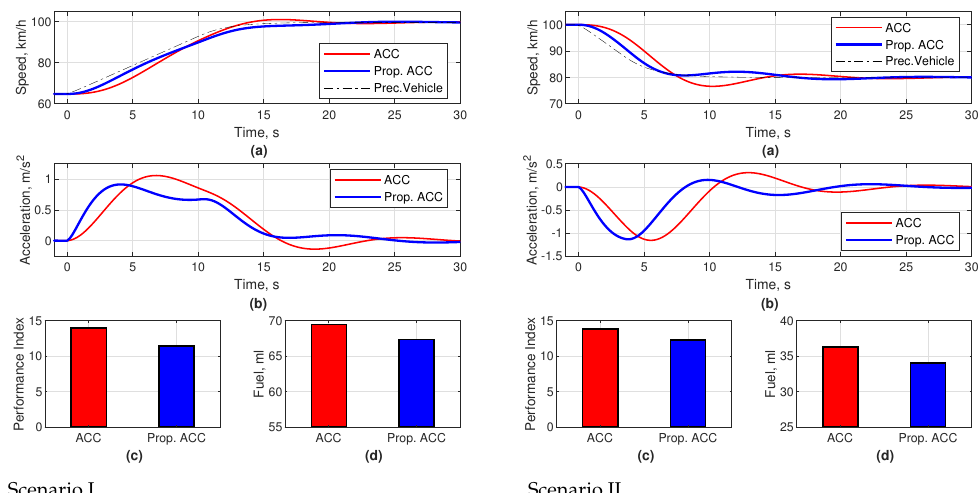
Figure 3. Evaluation of La-ACC and ACC in a simple car-following task in two scenarios. ( a ) Speed (speed of the preceding vehicle is shown by the dotted curve), ( b ) acceleration, ( c ) performance index, and ( d ) fuel